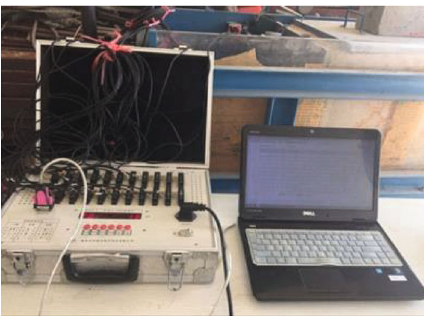
Figure 6: Data acquisition